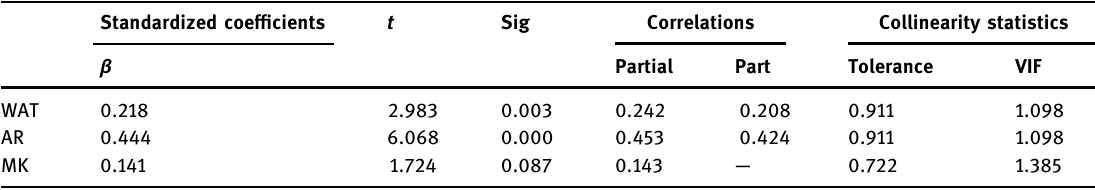
Table 3: Beta and coe ffi cients of all